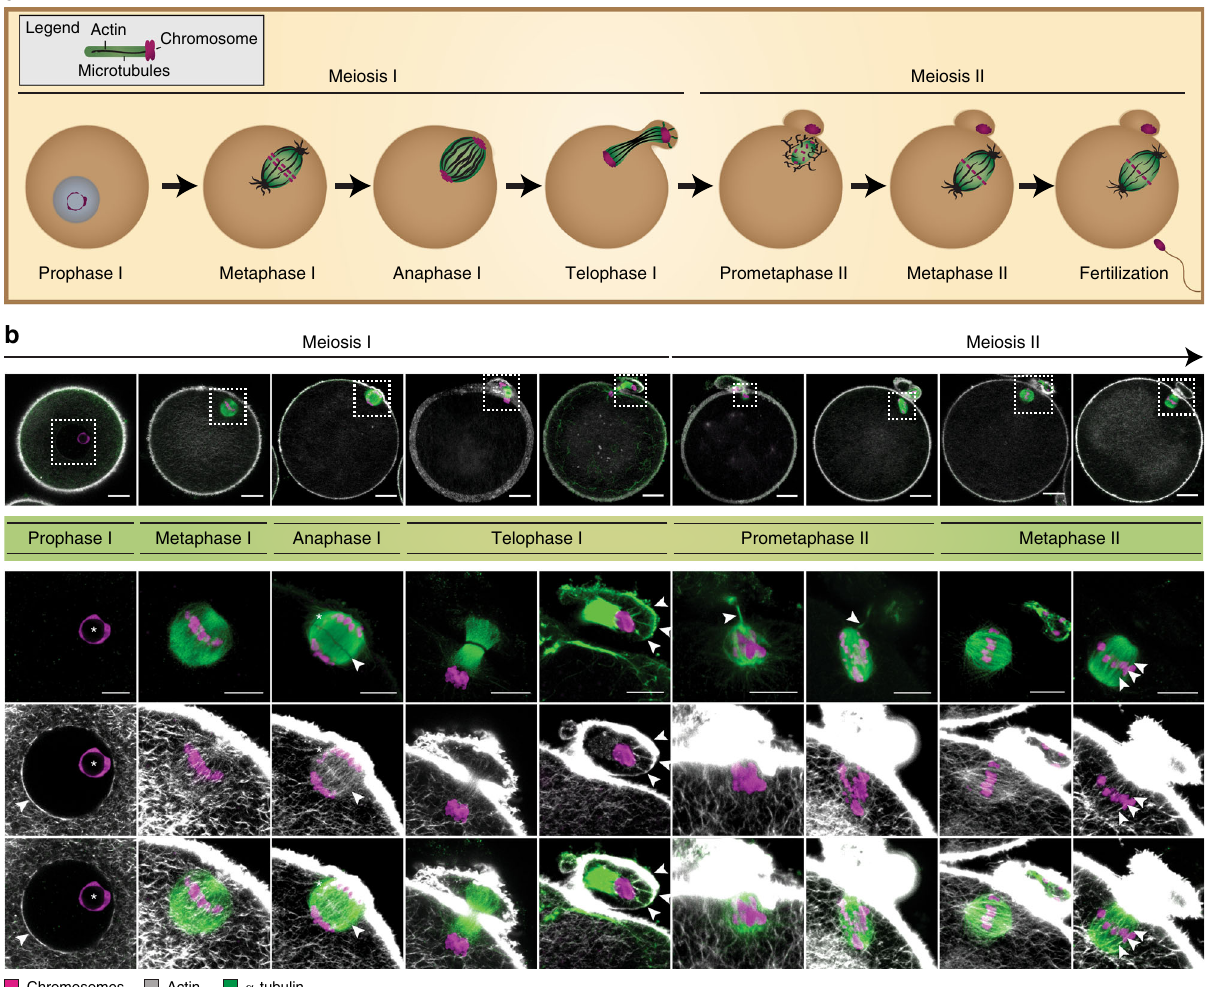
Fig. 2 Actin and microtubule dynamics are tightly coupled during oocyte meiosis. a Schematic illustration of the characteristic stages of oocyte meiosis showing chromosome, microtubule, and actin organization at the spindle. b Confocal z -projections of oocytes fi xed at different meiotic stages and stained for chromatin (Hoechst), actin (phalloidin), and microtubules ( α -tubulin). z = number of projected sections; Images are representative of n = number of oocytes per stage. Prophase I: arrowhead points at the membrane of the germinal vesicle and asterisk marks chromatin clustering around the nucleolus; z = 3 sections, n = 10 oocytes. Metaphase I: z = 3 sections, n = 9 oocytes. Anaphase I: arrowhead highlights the spindle midzone, asterisk marks a lagging chromosome; z = 11 sections, n = 1 oocyte. Telophase I: arrowheads highlight regions of chromatin anchorage; z = 3 and 6 sections, n = 6 oocytes. Prometaphase II: arrowheads mark microtubules projecting towards the polar body; z = 8 and 11 sections, n = 7 oocytes. Metaphase II: arrowheads highlight actin fi bers overlapping with microtubules; z = 6 and 8 sections, n = 15 oocytes. Scale bars are 20 μ m (overview) and 10 µ m